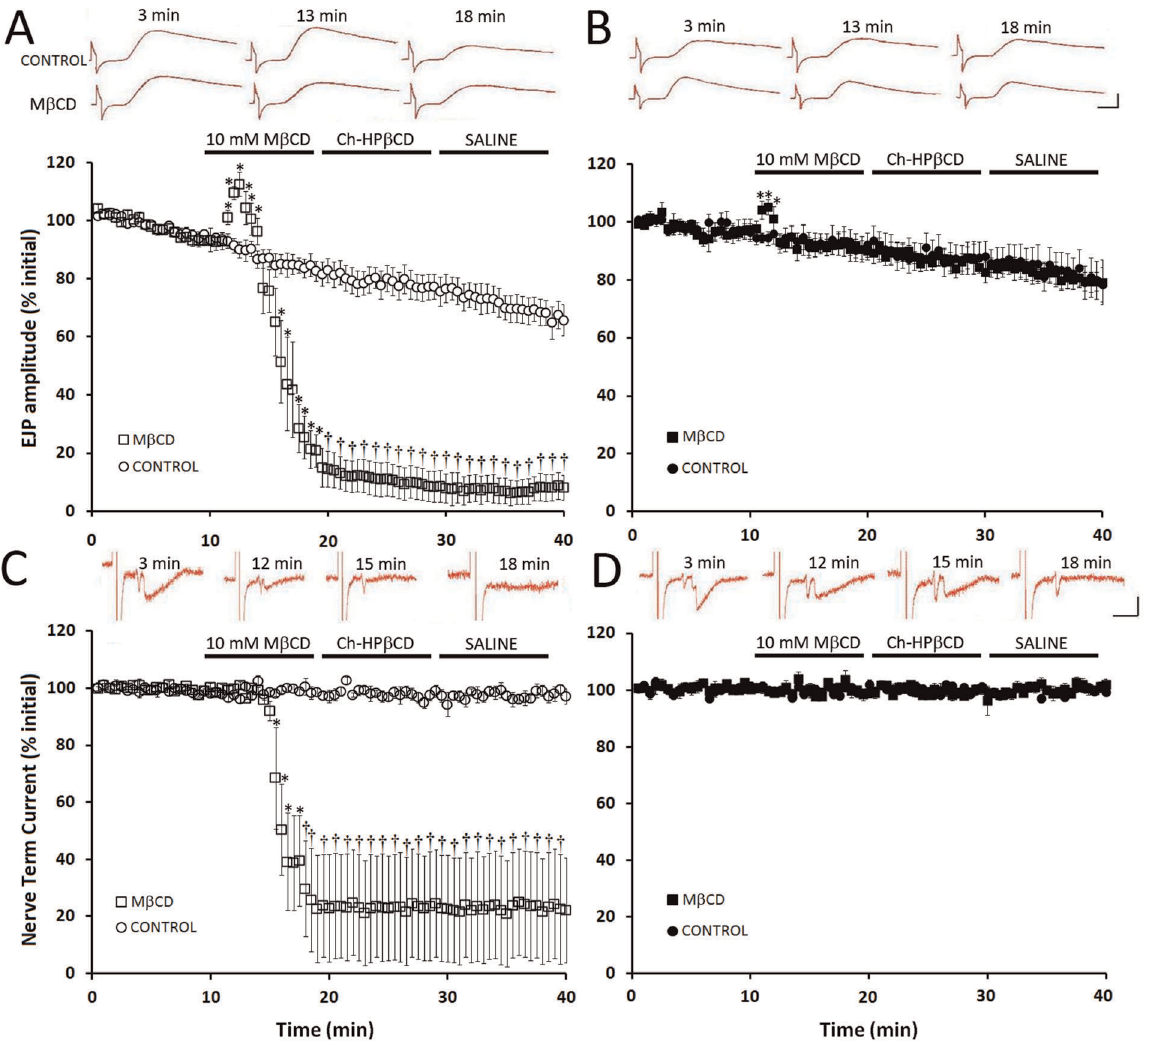
Figure 2. M b CD causes a reduction in EJPs which coincide with impulse failure only in neuromuscular preparations from cold- acclimatized animals. Intracellular recordings were made from L1 muscle fibers within the 4 th abdominal segment while simultaneously recording extracellularily through a loose patch electrode placed over a synapse. These recordings detect the propagating action potential (AP) invading the presynaptic terminal, the postsynaptic current following the AP, and an EJP. A . Cold-acclimatized group (open symbols). Control (no M b CD, open circles) depicts low-frequency depression, inherent during phasic stimulation. Application of 10 mM M b CD resulted in an initial significant (P , 0.05) transient increase in EJP amplitude followed by a rapid reduction in EJP amplitude (P , 0.05) which did not recover following the application of 10mM Ch-HP b CD or a subsequent saline wash. B . Warm-acclimatized group (closed symbols). Application of 10 mM M b CD resulted in an initial significant (P , 0.05) transient increase in EJP amplitude, which quickly returned to control values, and remained stable for the remainder of the recording period. Inset (A–B) shows recorded signals of EJPs at selected time points. Scale bars: 5 mV, 5 ms. C . Extracellularily recorded nerve terminal currents from cold-acclimatized animals. The nerve terminal current remained stable during the pre-application period; application of 10 mM M b CD resulted in a loss of the nerve terminal signal in 6/7 trials, consequently producing a marked reduction in the amplitude of the nerve terminal current (P , 0.05) which did not recover with the application of 10 mM Ch-HP b CD or a subsequent saline wash. D . Extracellularily recorded nerve terminal currents from warm-acclimatized animals. Application of 10 mM M b CD had no effect on the amplitude of the nerve terminal current. Inset (C–D) shows traces from loose patch recordings at selected time points. Initial downward deflection is the nerve terminal current, following by the post-synaptic current. Scale bars: 0.5 nA, 5ms. N=7. * indicates P , 0.05, { indicates P , 0.01.